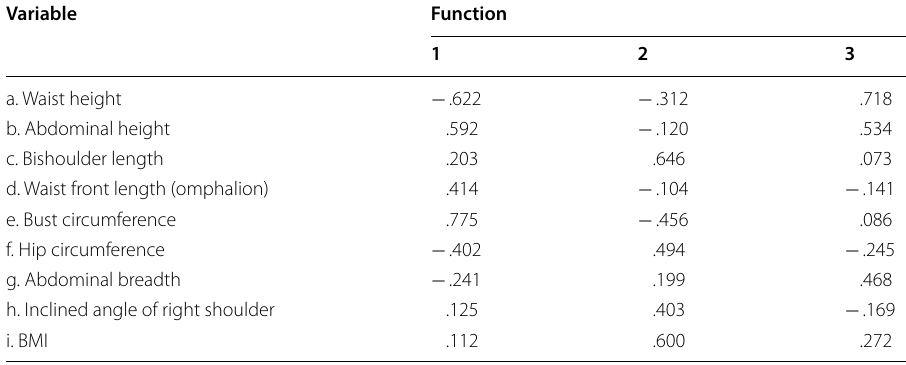
Table 11 Standardized canonical discriminant function coefficients Variable